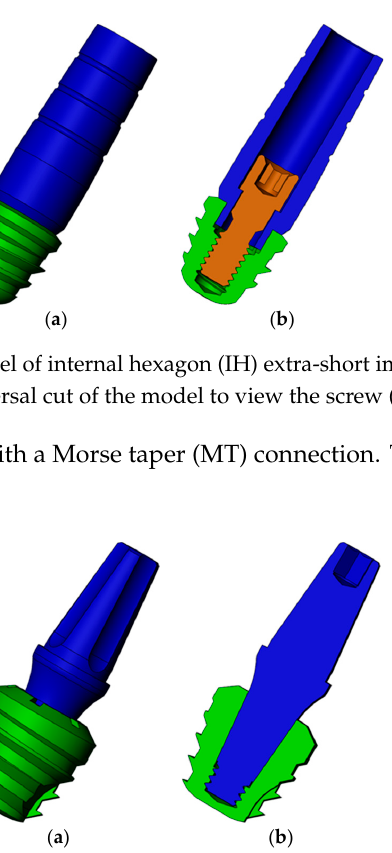
( d ) Figure 3. Jaw three-dimensional model: ( a ) Jaw with teeth; ( b ) edentulous jaw; ( c ) model of the extracted tooth; ( d ) tooth insertion in the edentulous mandible. In addition to the jaw, all models will have the following characteristics: •